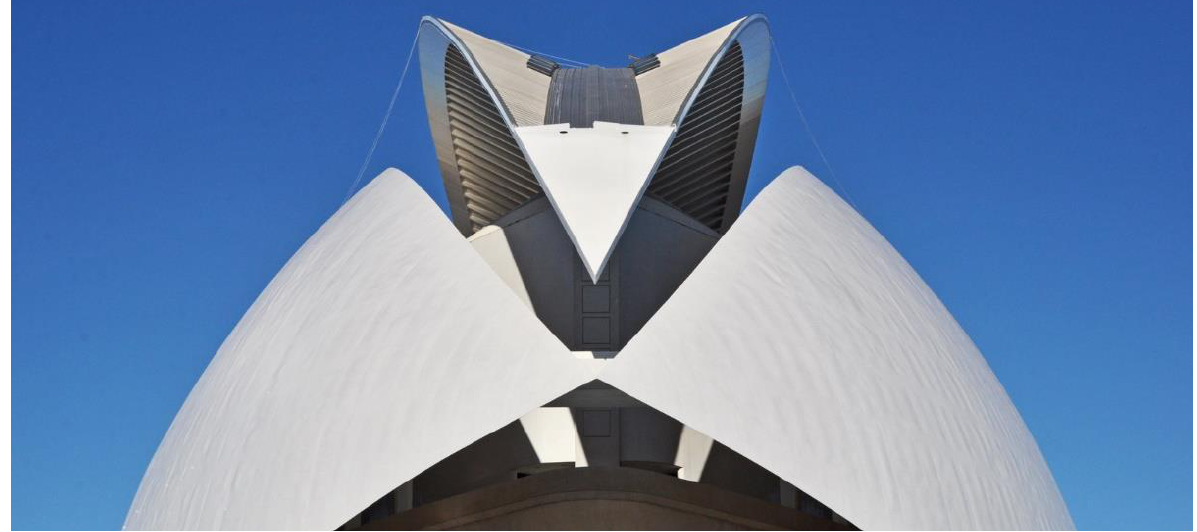
Figure 7. Palau de les Arts Reina Sofia, Valencia (2018). Photographer Hans Porochelt, Source: Flickr, https://www.flickr.com/photos/porochelt/42422451695/, Copyright License: CC Attribution-Non- Commercial-NoDerivs 2.0 Generic).